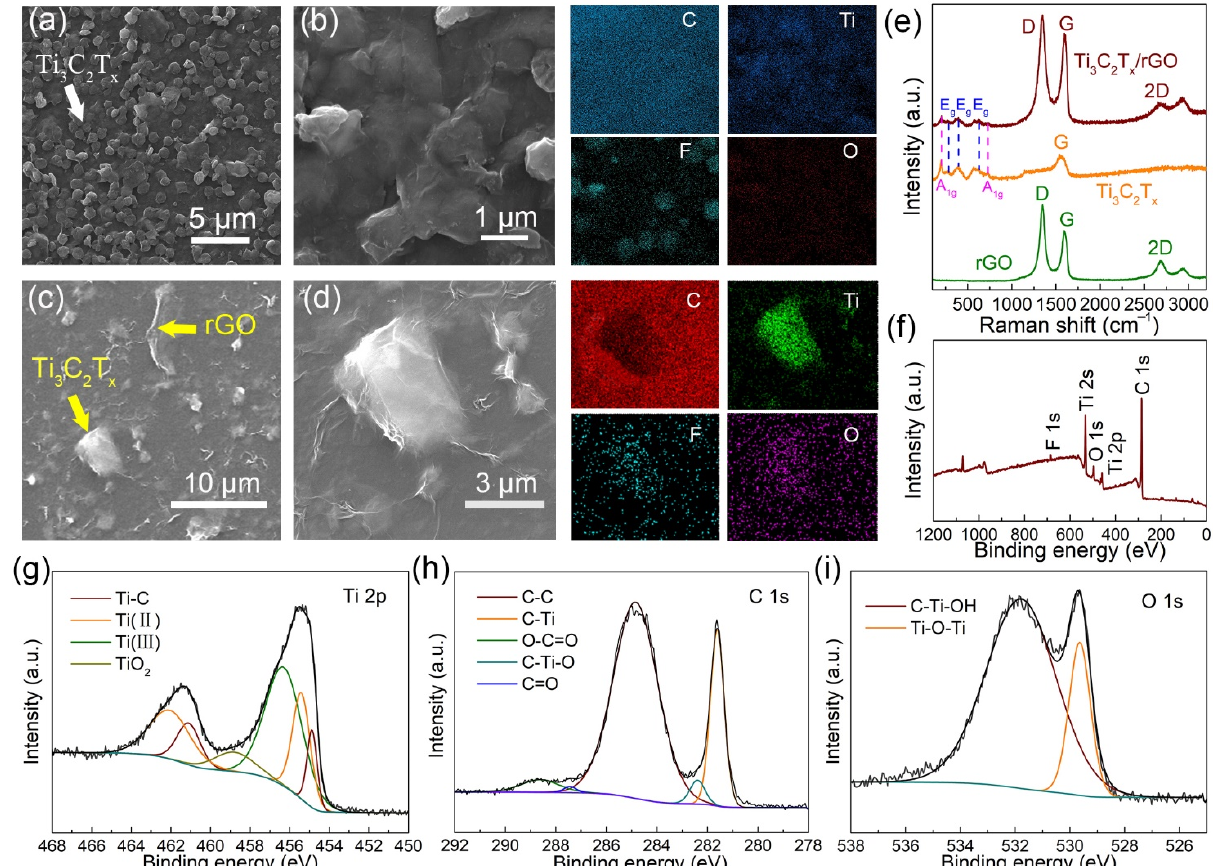
Figure 2. SEM images of Ti 3 C 2 T x electrode ( a ) and Ti 3 C 2 T x /rGO electrode ( c ). ( b , d ) Regional enlarged view of ( a , c ) and the EDS mapping of element distribution of C, Ti, F, O, respectively. ( e ) Raman spectra of Ti 3 C 2 T x , rGO, and Ti 3 C 2 T x /rGO nanocomposite. ( f ) XPS survey spectra of Ti 3 C 2 T x /rGO, and Ti 2p spectra ( g ), C 1s spectra ( h ), O 1s spectra ( i ) spectra, respectively.